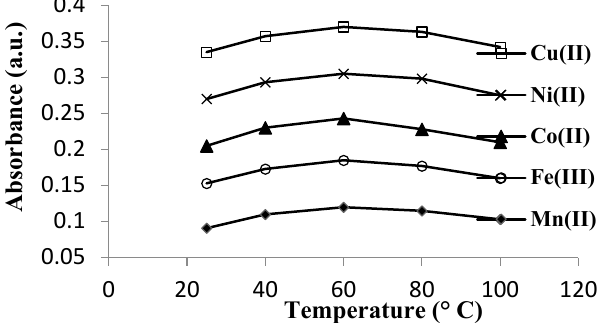
Figure 4. Determination of the optimal reaction time for the synthesis of complexes between ligand with temperature. L and metal cation M (Mn 2+ , Fe 3+ , Co 2+ , Ni 2+ , and Cu 2+ ) using a spectrophotometric method.